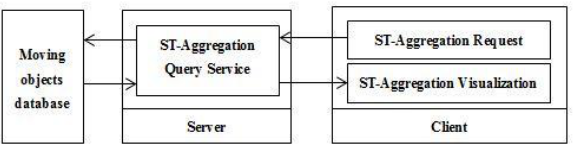
Figure 4. Architecture of aggregation query service